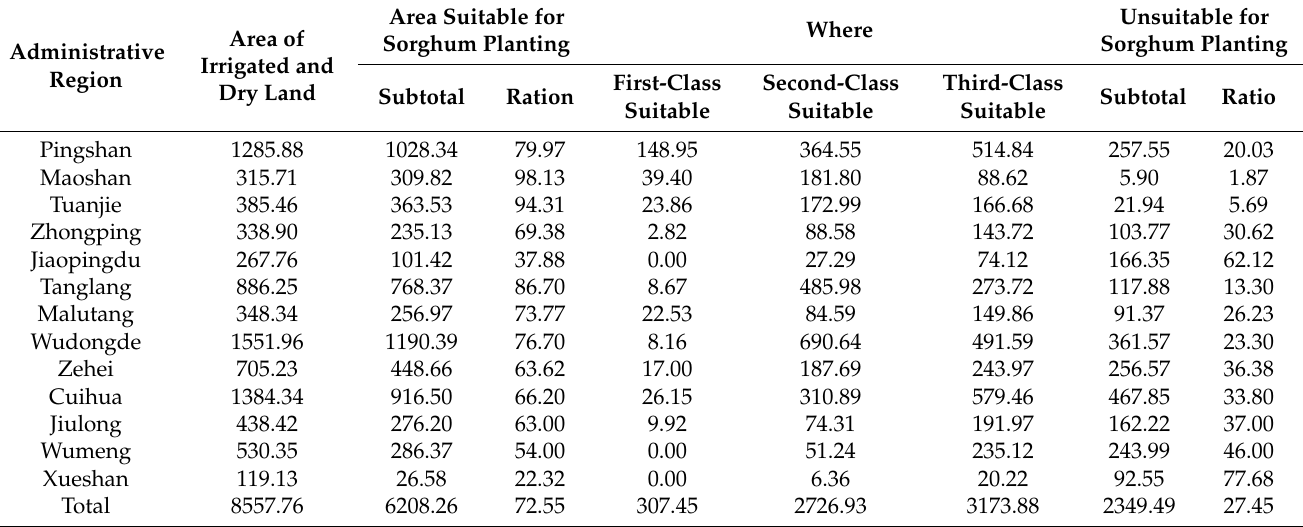
Table 6. Irrigated and dry land area of land suitability grade of sorghum planting in Jinsha River Basin of Luquan County (Unit: ha, %).